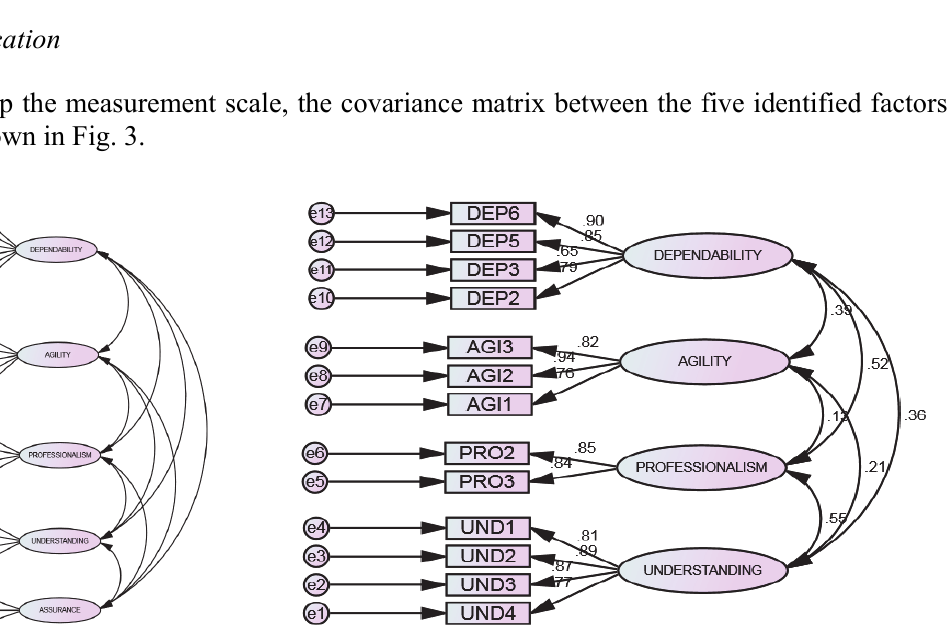
Fig. 4. CFA Model Development for measuring Employees’ Service